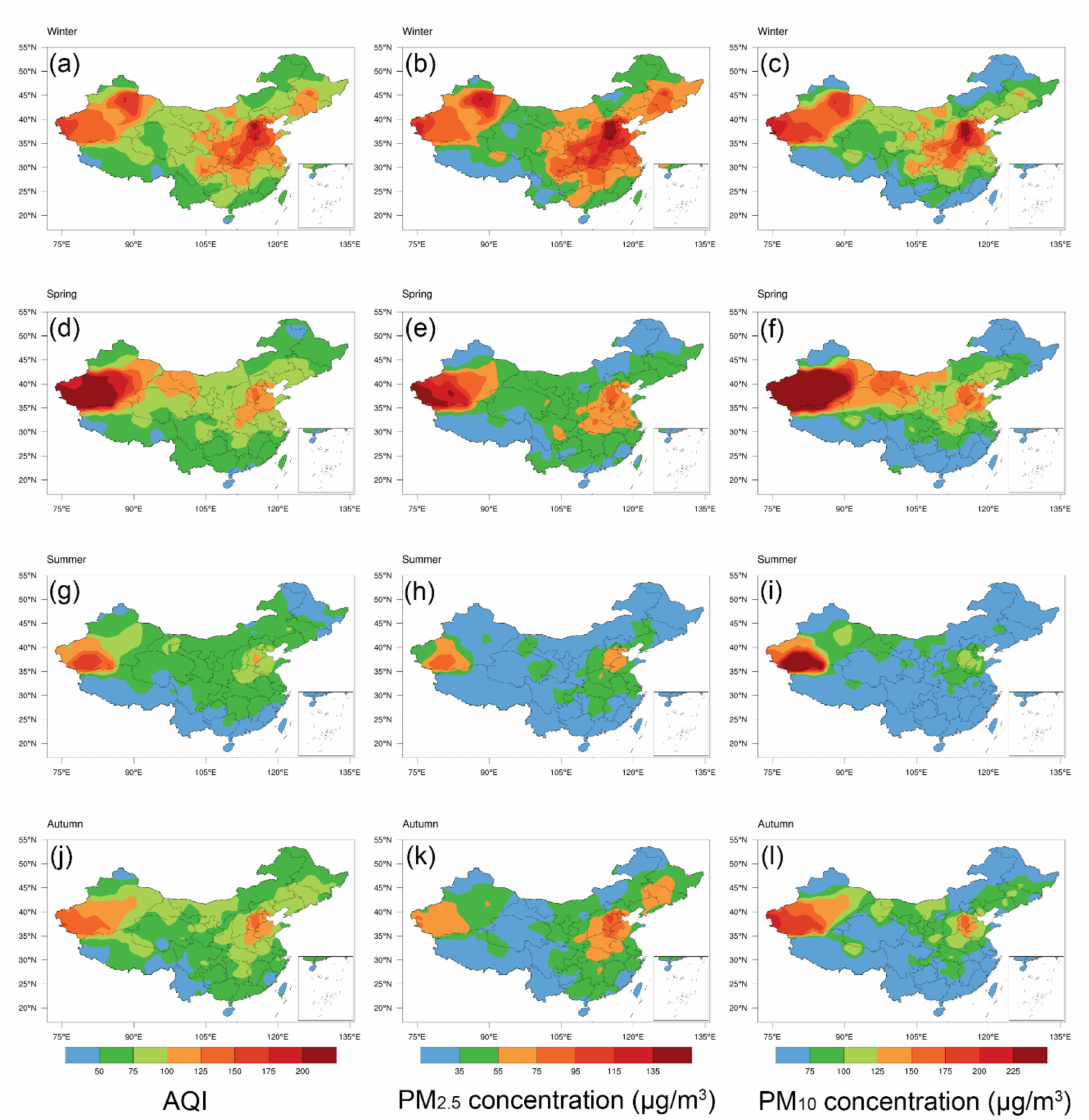
Figure 2. The spatial distributions of seasonal average AQI, PM 2.5 concentration, and PM 10 concentration during ( a – c ) winter, ( d – f ) spring, ( g – i ) summer, and ( j – l )